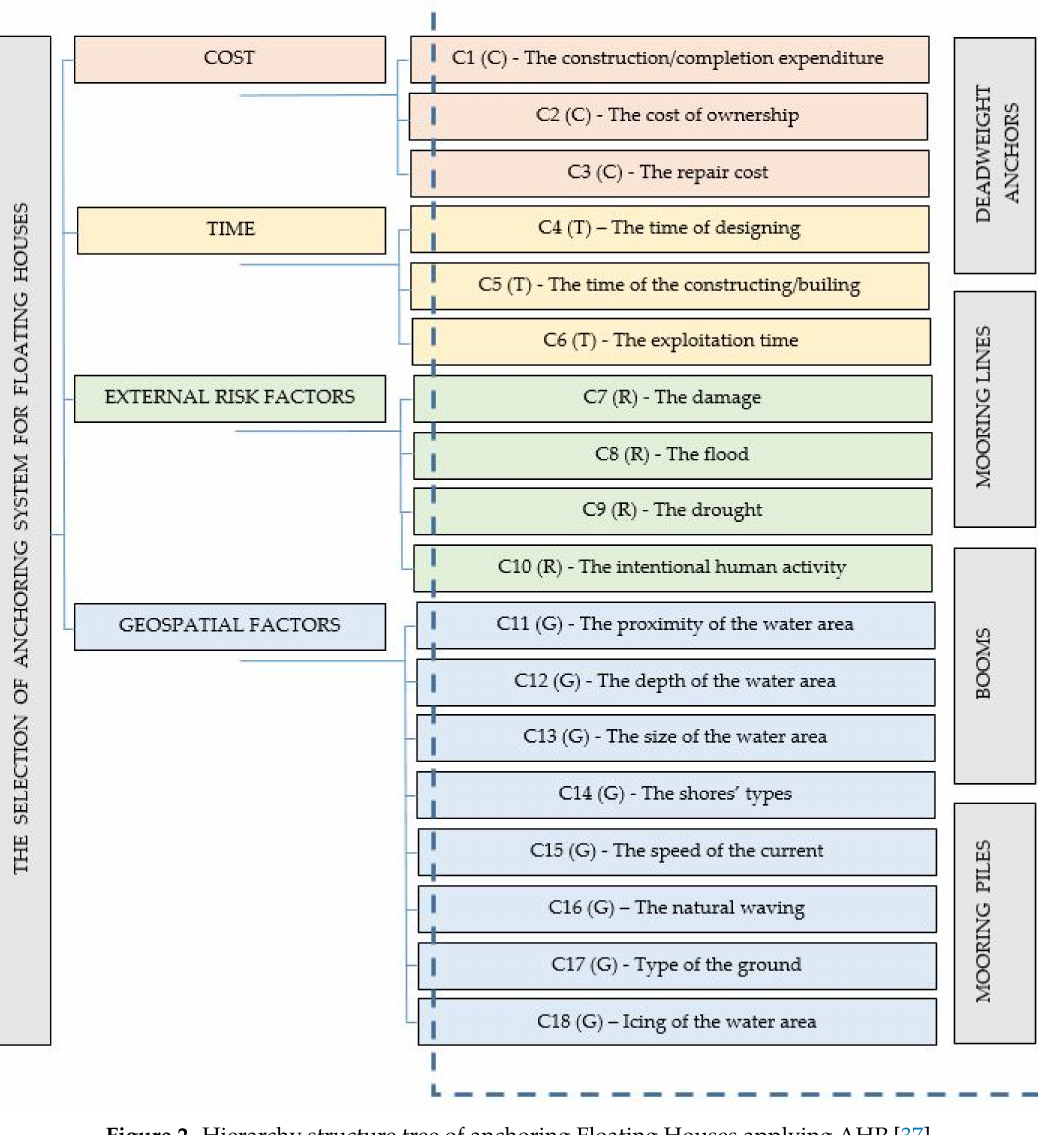
Figure 2. Hierarchy structure tree of anchoring Floating Houses applying AHP